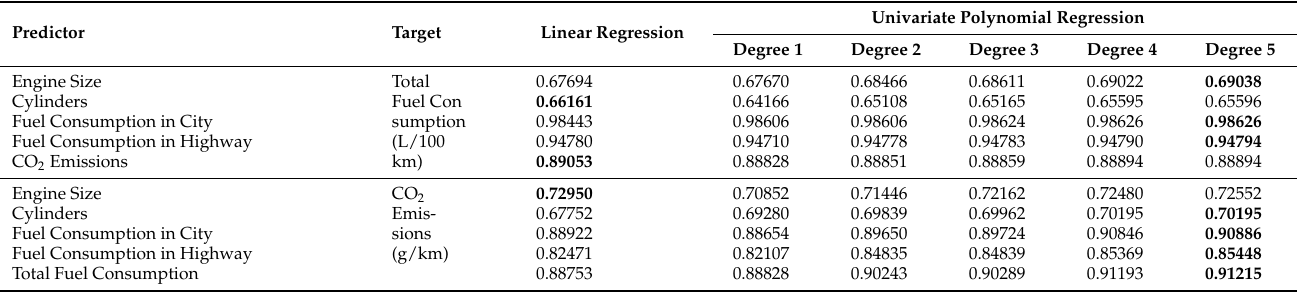
Table 12. Coefficient of determination (R squared) values of Linear Regression and Univariate Polynomial Regression